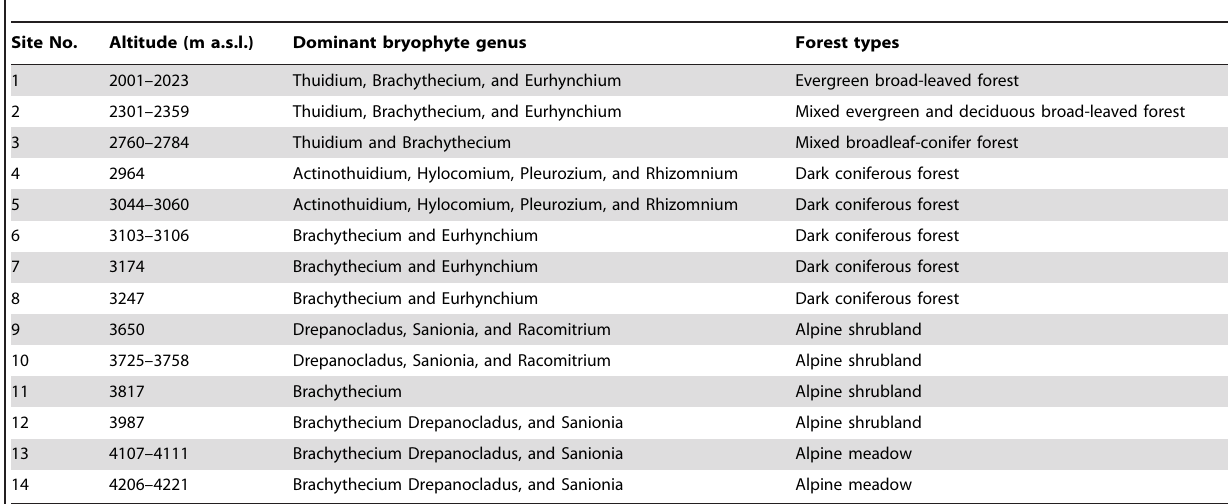
Table 3. Forest types and the most-prevalent bryophyte genus along the altitudinal gradient.